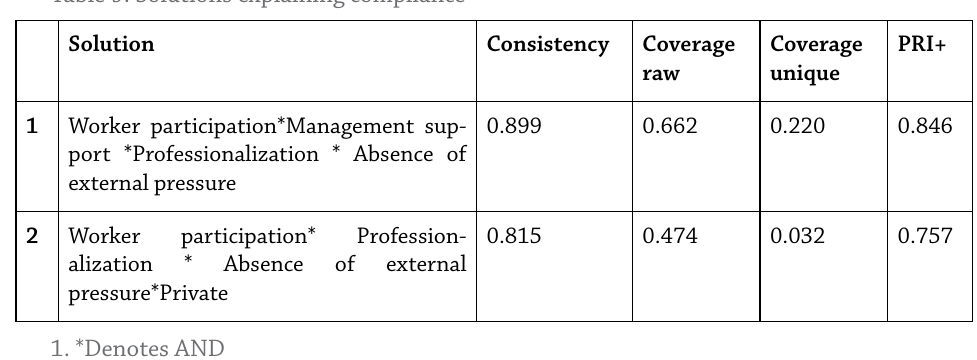
Table 9: Solutions explaining compliance